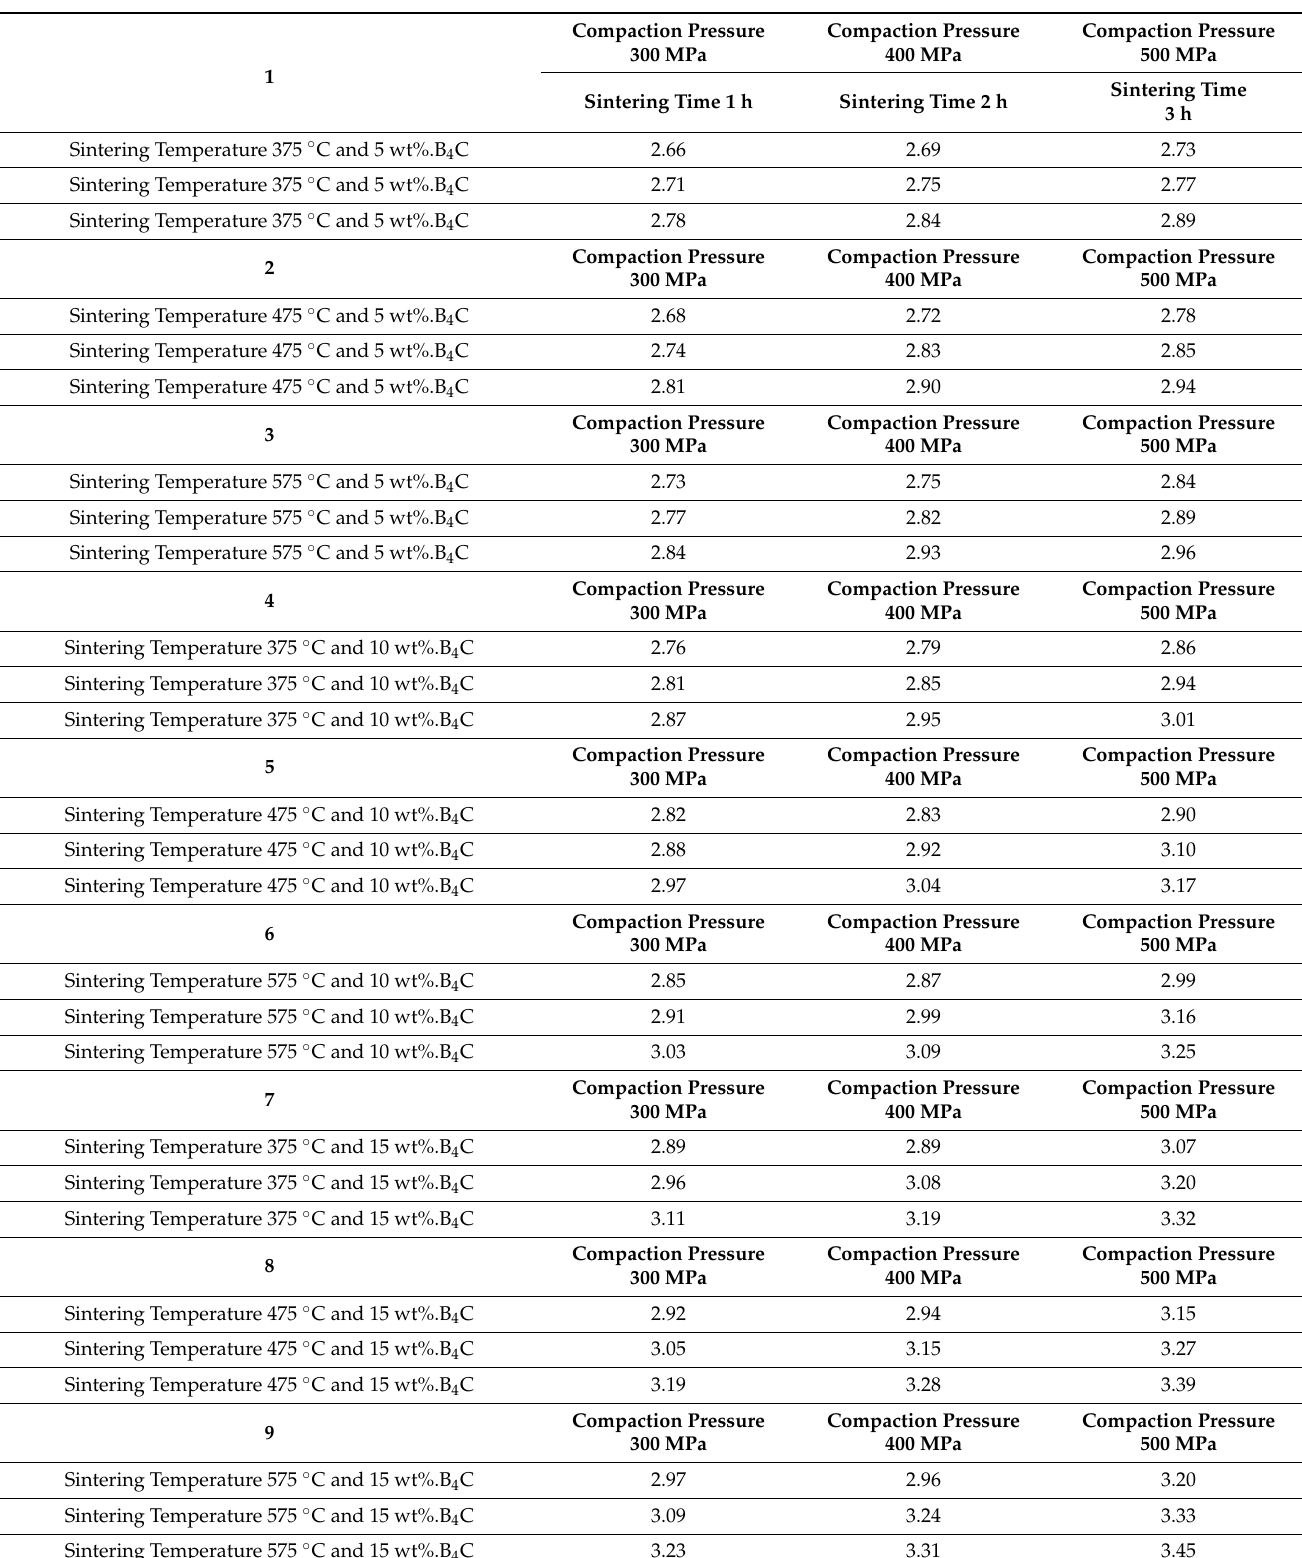
Table 1. Effect of PM parameters on density at different compaction pressure (300, 400, and 500 MPa), different sintering time (1, 2, and 3 h), different sintering temperature (375, 475, and 575 ◦ C), and different reinforcement weight percentages (5 wt%., 10 wt%., and 15 wt%.B 4